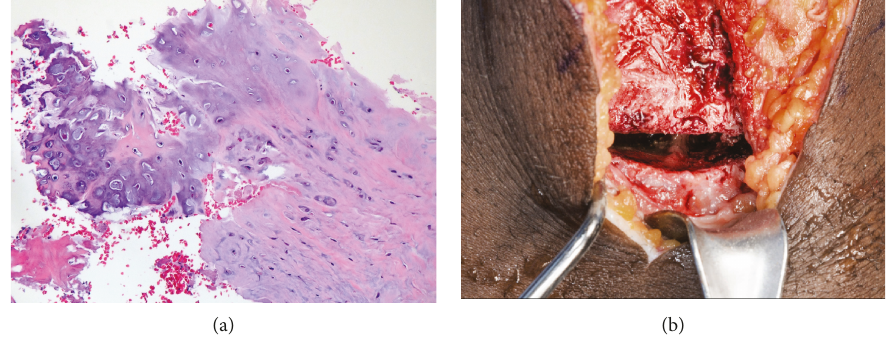
Figure 3: (a) Left proximal tibia specimen showing fragments of nonossifying hyaline cartilage with admixed fi broconnective tissue consistent with persistent physis (H&E; 200x). Histological examination of the left proximal tibia tissue specimen showed fracture callus comprising mixed chondroid/ fi broconnective tissue undergoing ossi fi cation. Examination of the right proximal tibia tissue specimen obtained six weeks later demonstrated numerous admixed fragments of purple to purple-gray staining myxochondroid matrix suggestive of chondroid metaplasia, which is not an expected fi nding in this anatomic location distal to the articular surface. This presence of cartilage at this location is again consistent with a persistent physis. (b) An intraoperative photograph of right proximal tibia status post debridement of fi brous material at the site of prior